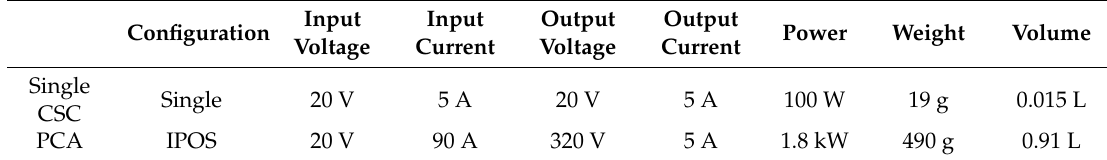
Table 1. Main characteristics of a single CSC and the PCA introduced as an illustration.